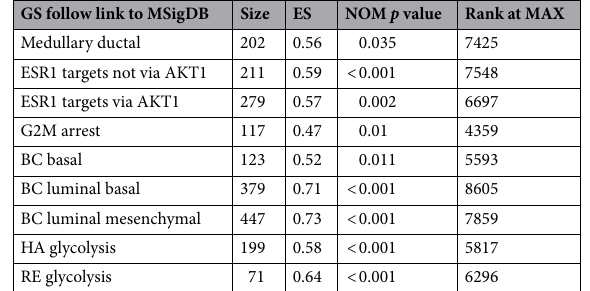
Table 1. Gene sets enriched in Breast